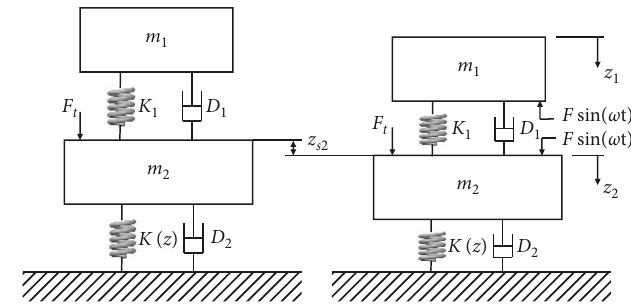
Figure 2: Dynamic model of the vibrator.